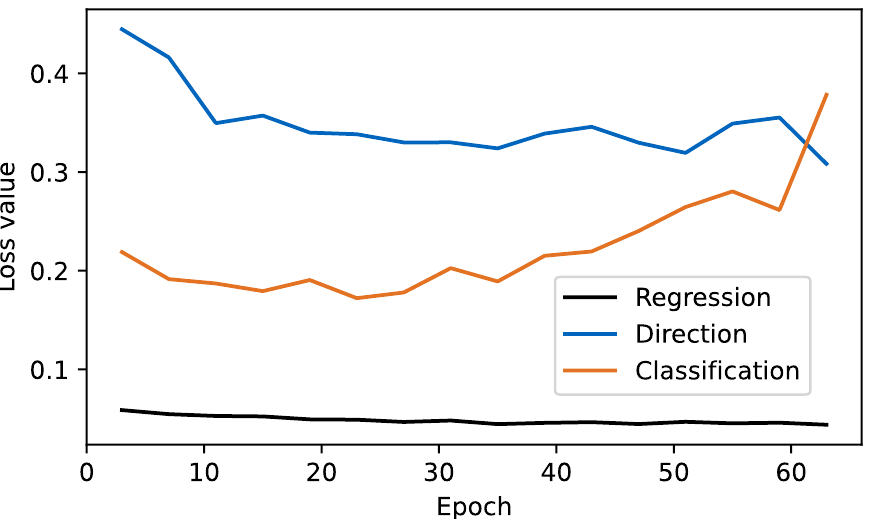
Figure 5. Loss values of the RVF-Net. The classification loss starts to overfit around epoch 30 while regression and direction loss continue to